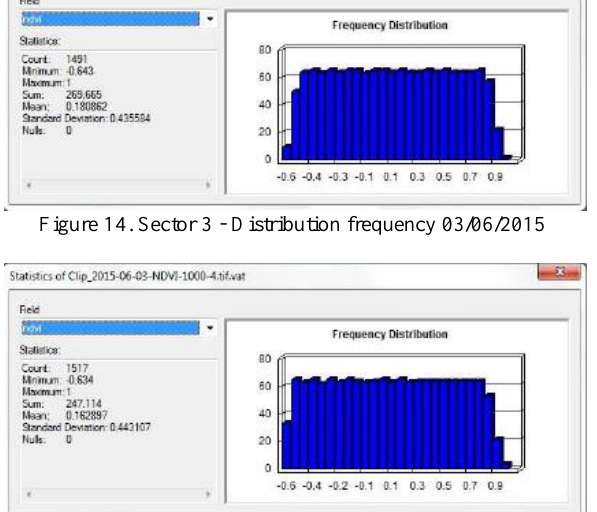
Figure 15. Sector 4 - Distribution frequency